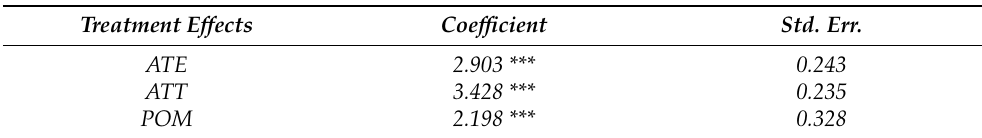
Table 6. Augmented inverse probability-weighted treatment effects on the adoption of climate change adaptation